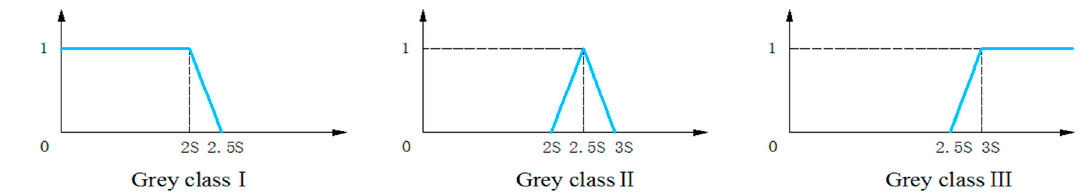
Figure 8. Schematic diagram of the definite weighted function.